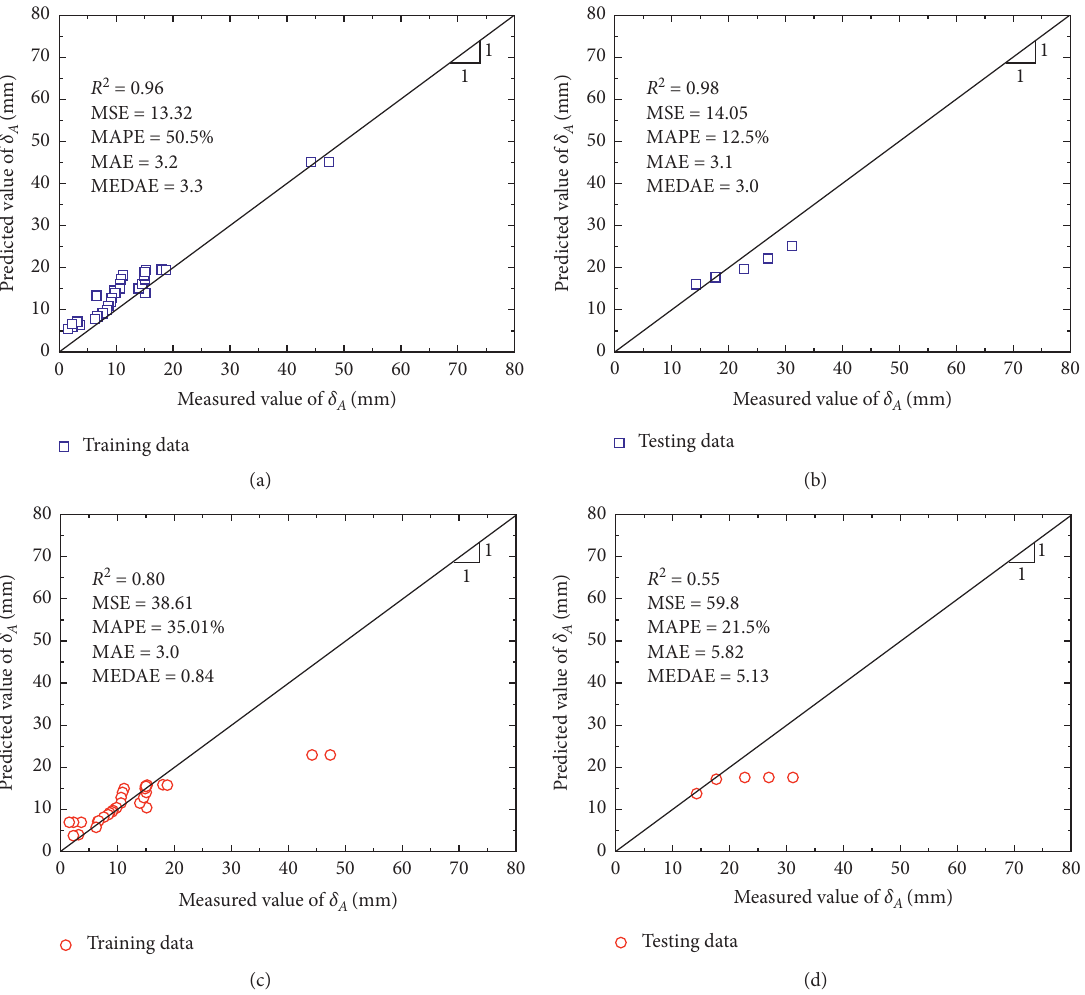
Figure 5: Prediction performance of ground displacement with different methods: (a) MNLR model (training); (b) MNLR model (testing); (c) SVR model (training); (d) SVR model